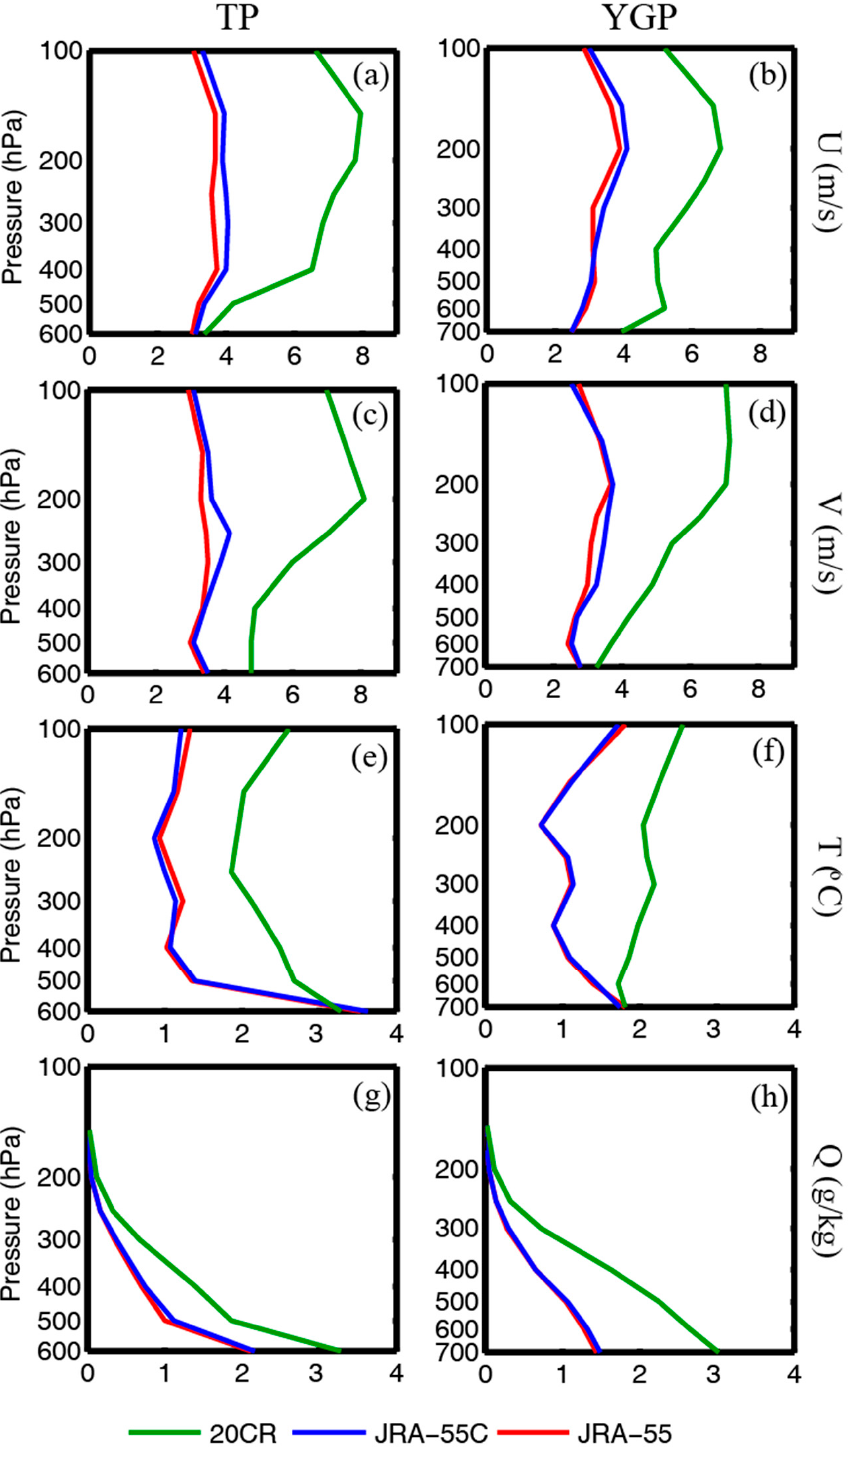
Figure 4. Vertical profiles of the mean RMSEs of ( a ) ( b ) U, ( c ) ( d ) V, ( e ) ( f ) T, and ( g ) ( h ) Q averaged over the independent soundings at ( left ) TP and at ( right ) YGP, respectively, for each reanalysis against the observations during the 2008 JICA/Tibet Project IOP.